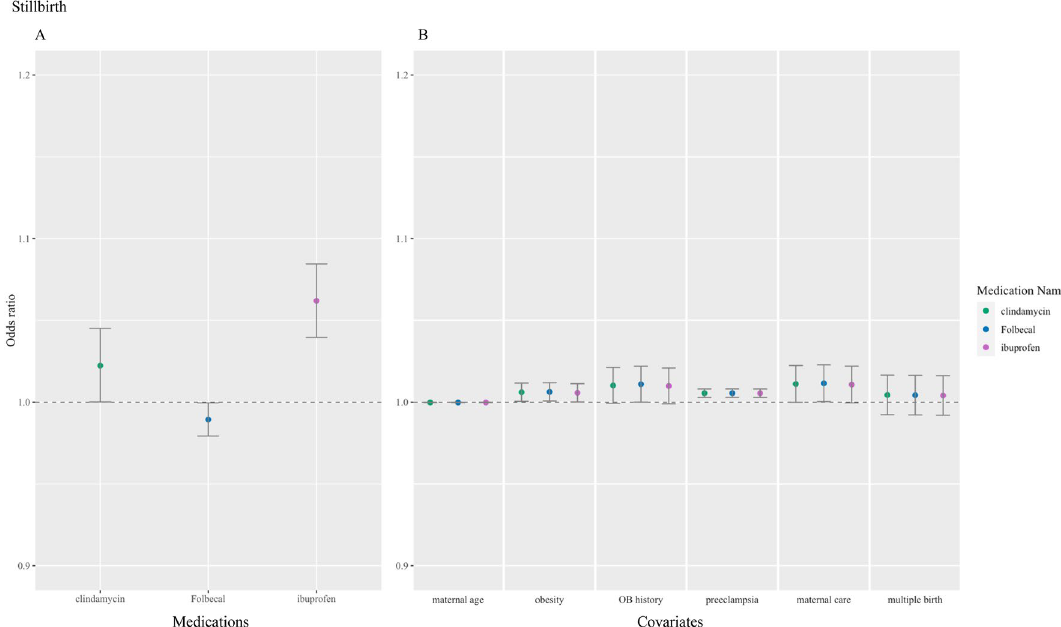
Figure 4. Medications and covariates significantly associated with stillbirth, odds ratio (95% confidence intervals). Plotted by ( A ) significant medications and ( B ) significant